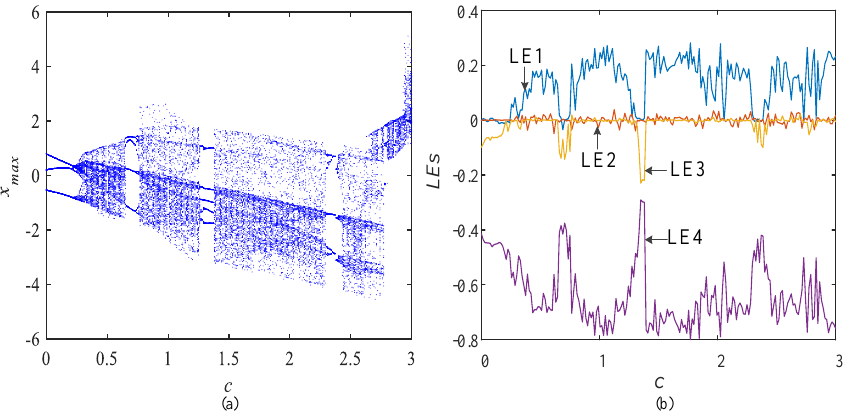
Figure 5. Dynamics with c change: ( a ) bifurcation diagram; ( b ) Lyapunov